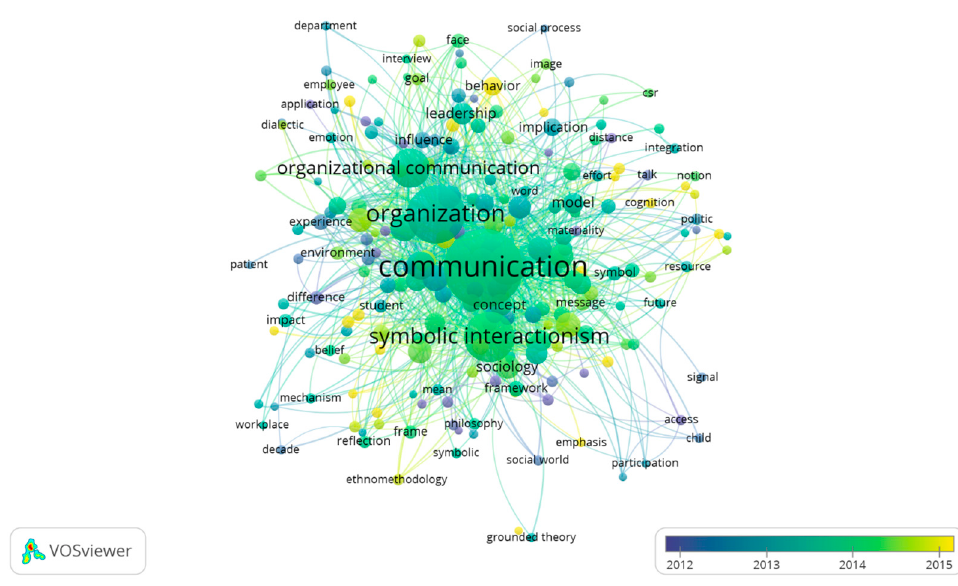
Figure 1. Identification and analysis of research problems related to social identity in an organization framed in relation to symbolic interactionism. Source: processed by researchers from Vosviewer 2022.